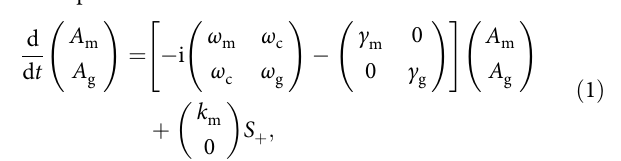
Supplementary Table 1 and were determined by a fi t to the numerical simulation considering energy conservation and time reversal symmetry 18 , reproducing the spectral features in the numerical results. Note that the scattering dip does not go to zero because of the introduction of loss in the guided mode ( γ g > 0; see Supplementary Fig. 5). The good agreement of numerical and TCMT results validates the assignment of the scattering dip as a scattering dark state resulting from coupling between a Mie resonance and BGS. Similar calculations with different geome- trical parameters (Supplementary Fig. 6) show that the effect is fully tunable from visible through infrared wavelengths by changing d and p with a fi xed δ